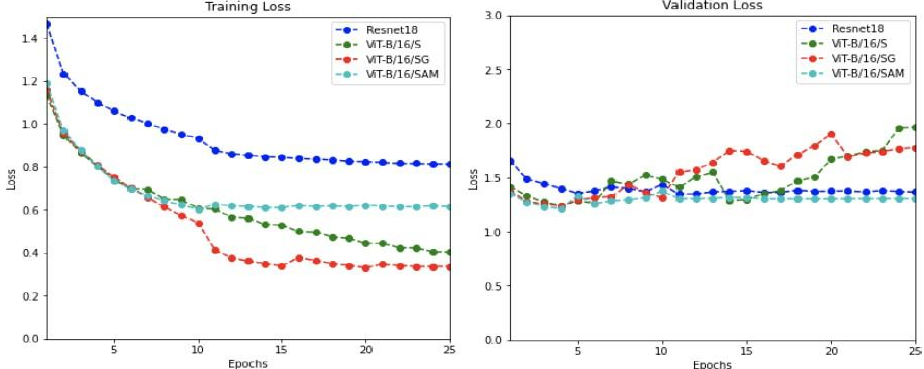
Figure 11. Training and validation loss for ResNet-18 vs. ViT-B/16 models.